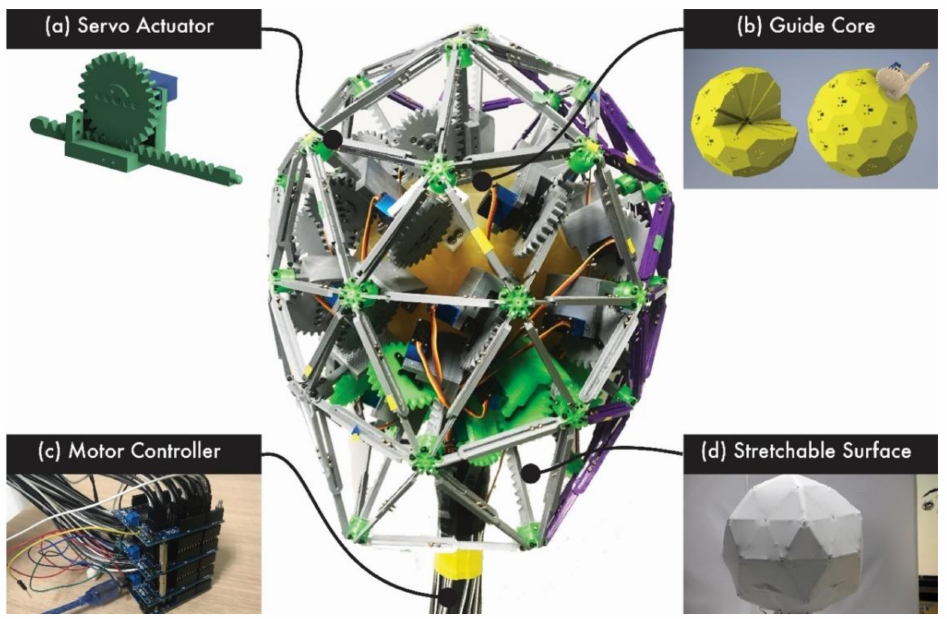
Figure 14. Hardware components: ( a ) servo actuator, ( b ) guide core, ( c ) motor controller, and ( d ) stretchable